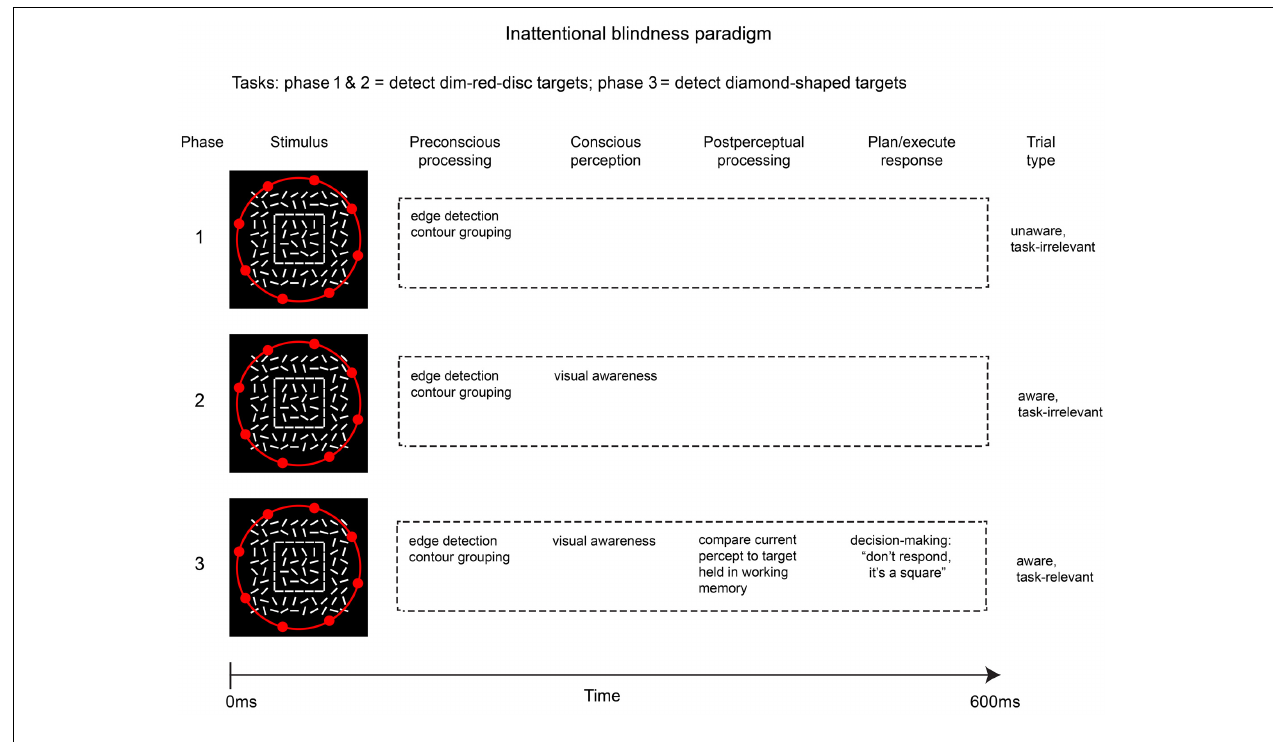
FIGURE 2 | Outline of the modified inattentional blindness paradigm used by Pitts et al. (2012). Because the critical stimulus (square shape) is task-irrelevant in phases 1 & 2, post-perceptual processing is avoided while